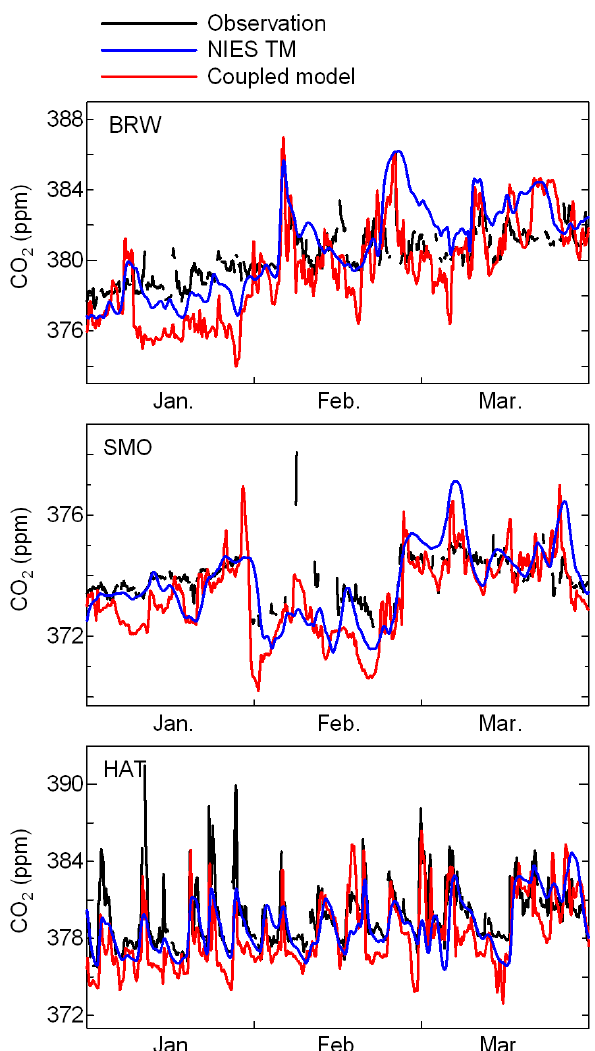
Figure 1. CO 2 concentrations at Barrow (BRW, top), Samoa (SMO, middle), and Hateruma (HAT, bottom) from January to March 2003. Black lines: observations; blue lines: NIES TM; red lines: coupled model.